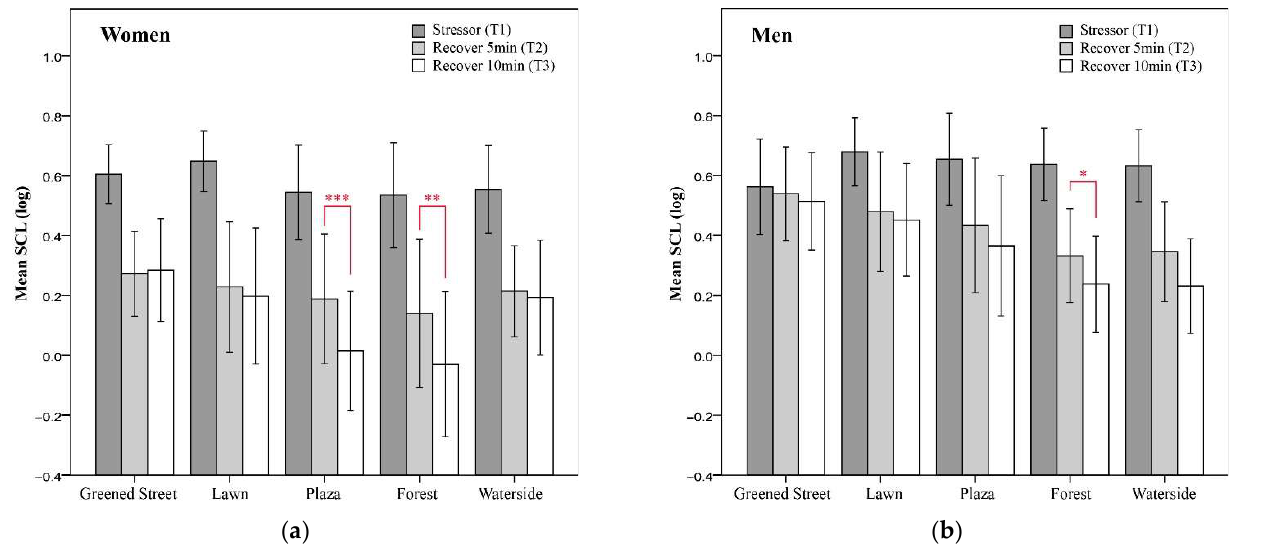
Figure 4. Changes in mean skin conductance level (SCL) of women ( a ) and men ( b ) in different environments during the recovery phase. Pairwise comparisons between minute 5 of recovery (T2) and end of the recovery (T3) in each environmental condition were marked. * p < 0.05, ** p < 0.01, *** p < 0.001.